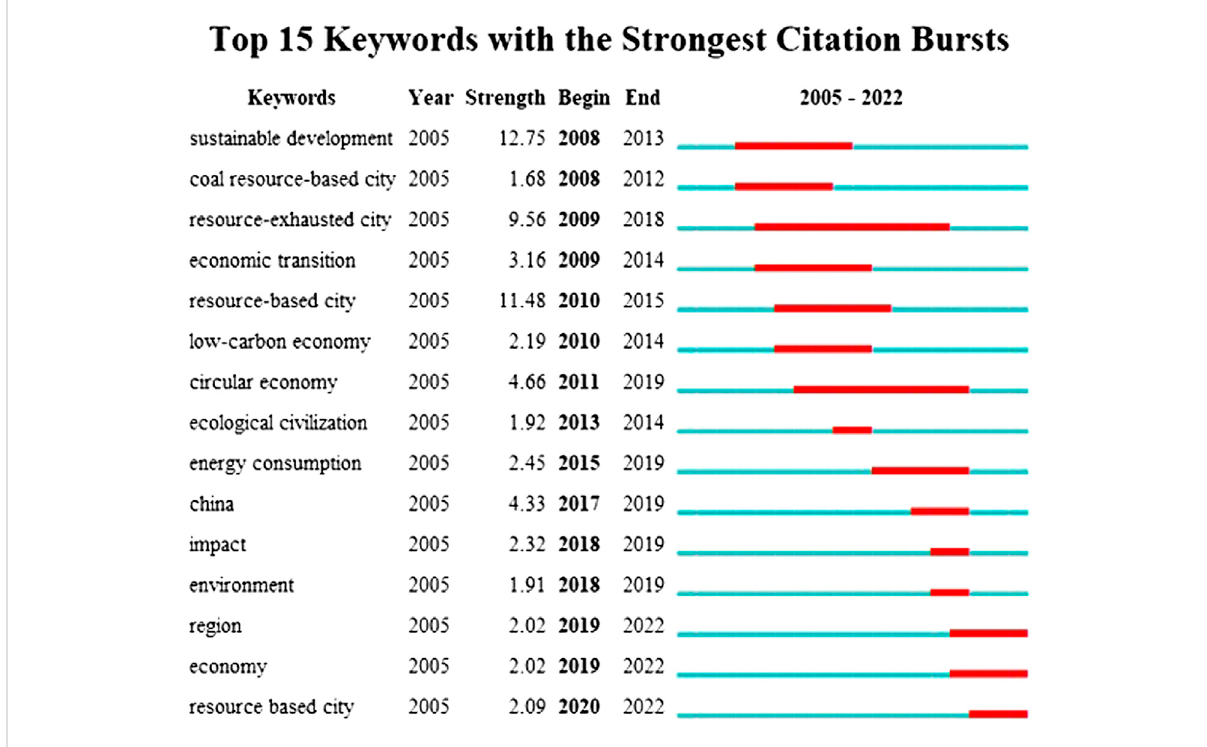
FIGURE 5 Analysis of keyword emergence in the WOS